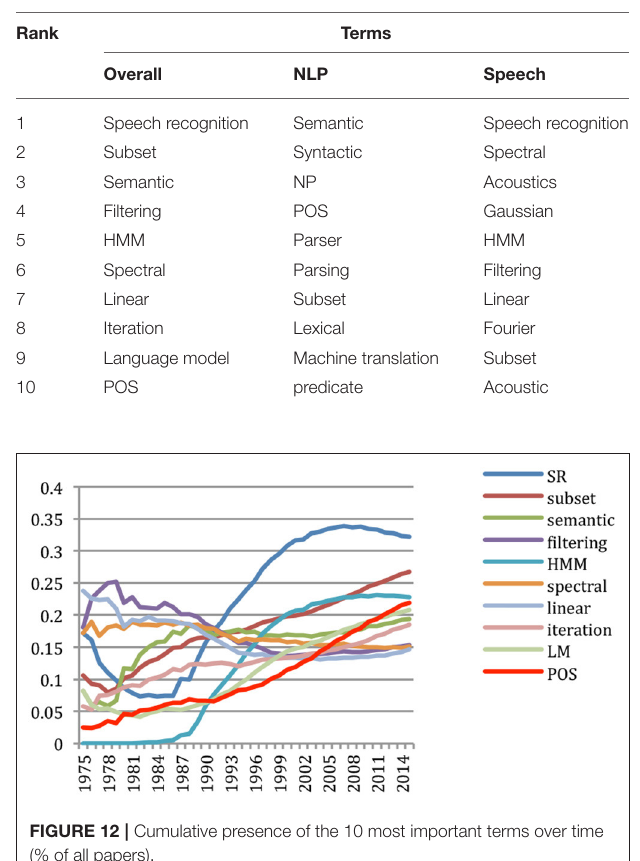
TABLE 4 | Global ranking of the importance of the terms overall and separately for Speech and NLP.